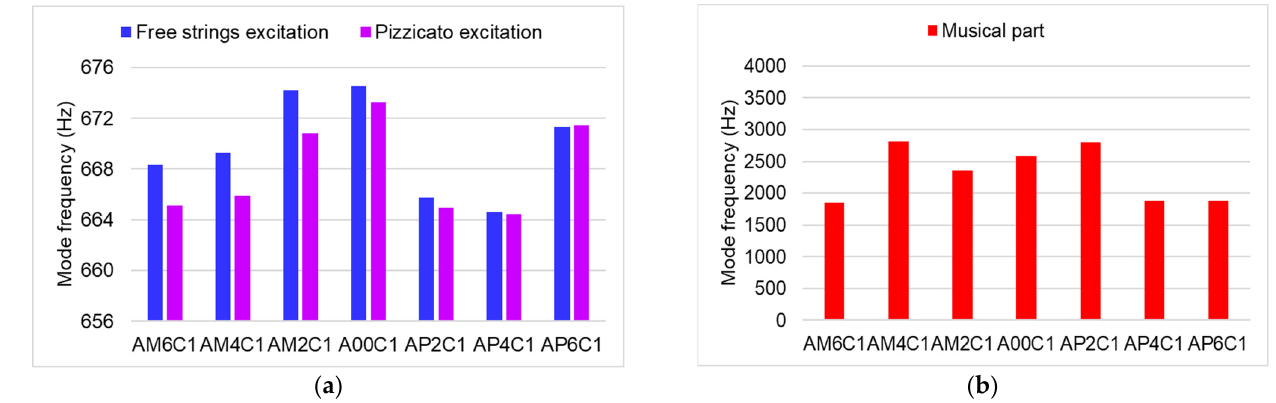
Figure 7. The mode frequency in the case of: ( a ) free string and Pizzicato excitation; ( b ) musical part.